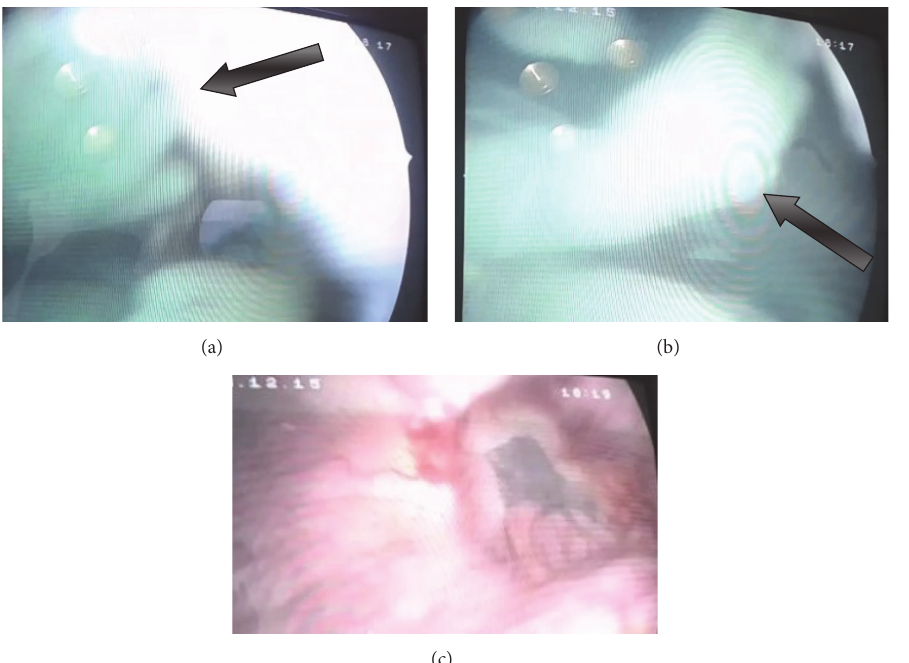
Figure 2: Images obtained at cystoscopy. ((a) and (b)) a dead fetus in the bladder cavity and the fetus’ arms are visualized (arrows). (c) A mouth of fistula from the bladder